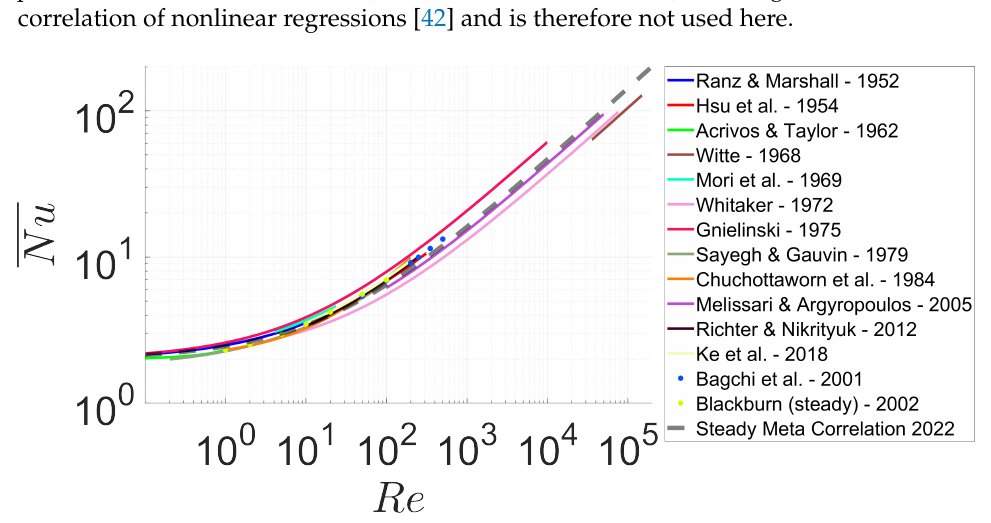
Figure 3. Overview of considered experimental and numerical HMT data for single spherical particles in steady flow. Solid lines indicate correlations provided by the respective authors, while single points indicate individual measurements or simulation points without correlations provided by the authors. Additionally, Steady Meta-Correlation (2) is plotted, which is fitted to the listed data. The Prandtl number is set to Pr = 0.71 as it can be found with air at STP. All the sources of the data are listed in Table